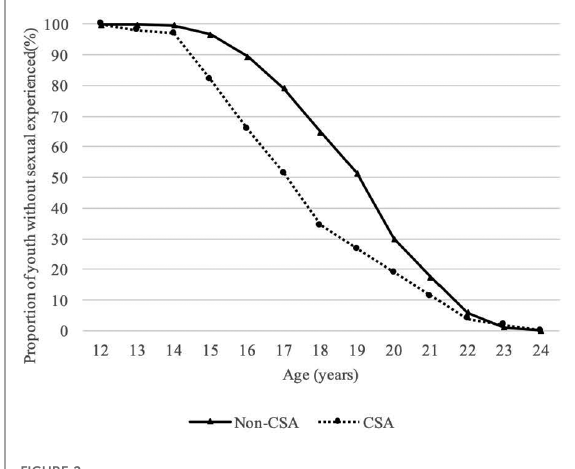
FIGURE 2 Proportions of Chinese youth who have never had a sexual experience by CSA exposure and age. CSA, childhood sexual